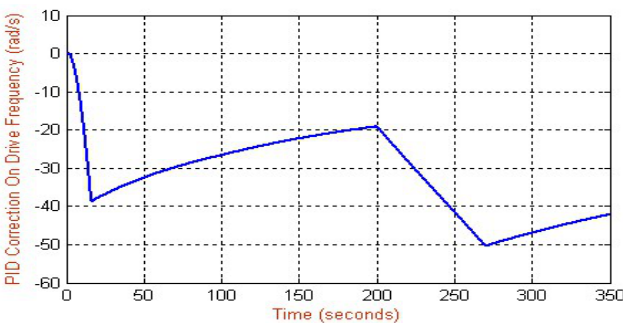
Figure 19. PID drive frequency correction versus time.